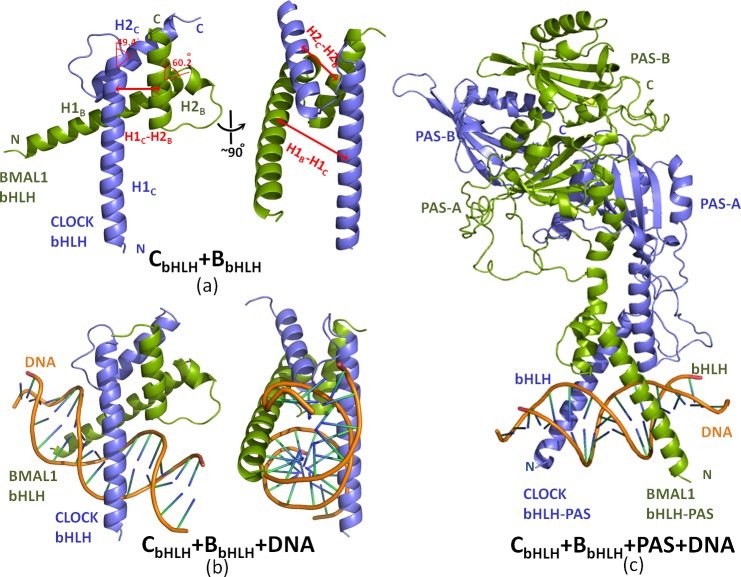
Structures of three models for the CLOCK and BMAL1 proteins, and DNA.Average simulated structures for (a) the CbHLH+BbHLH model, (b) the CbHLH+BbHLH+DNA model, and (c) the CbHLH+BbHLH+PAS+DNA model.